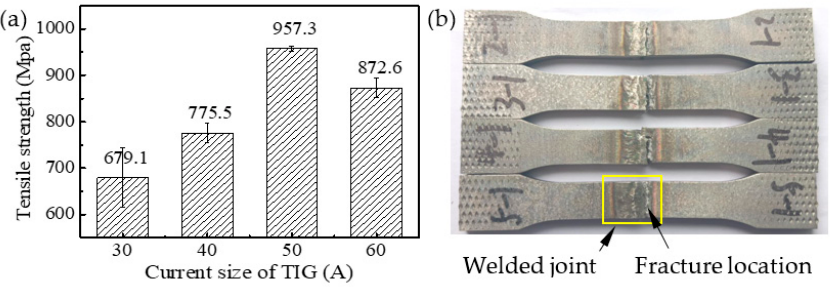
Figure 17. Tensile test results of welded joints with different currents: ( a ) tensile strength; ( b ) fracture